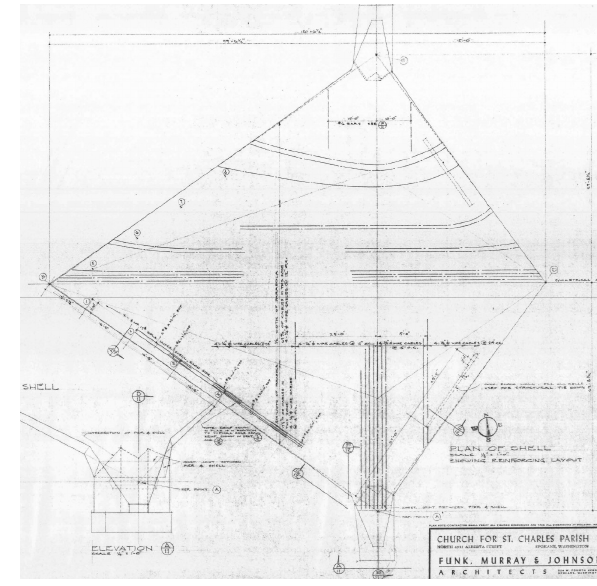
Figure 3: Plan drawing of the shell roof